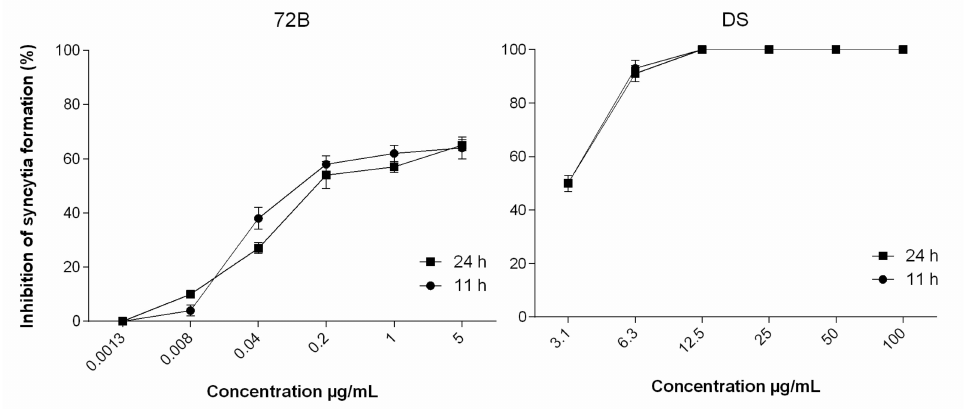
Figure 4. Reduction of syncytia formation. Number of syncytia at 11 (circles) and 24 (squares) hours, following treatment of C8166-H9IIIB cocultures with di ff erent concentrations of ethyl acetate branches extract (72B) and dextran sulfate (DS). The inhibition of fusion between normal C8166 cells and HIV-1 IIIB chronically infected H9 cells was quantified under an inverted